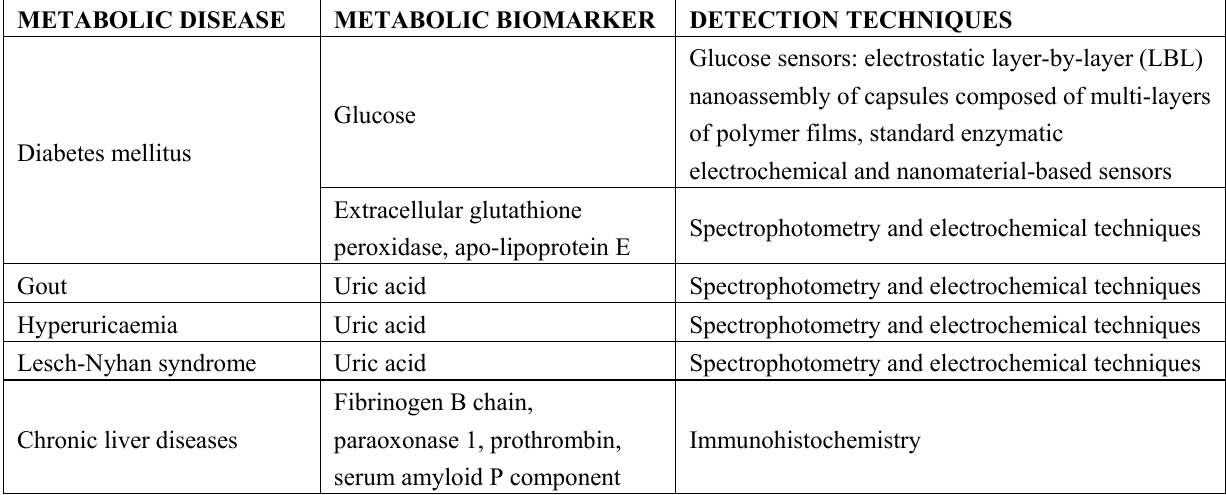
Table 4. A list of metabolic biomarkers detected by novel sensors based on nanoproteomics approaches. METABOLIC